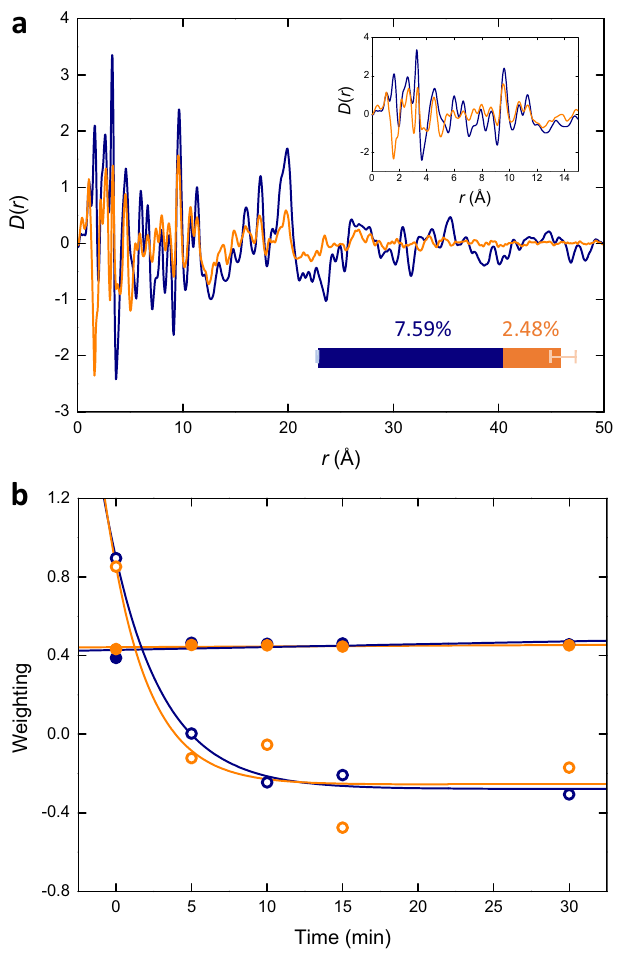
Fig. 6 Kinetic insight. a Comparison of the second principal components (distortions) obtained from the structural collapse of MIL-100 (navy) and Fe-BTC (orange). Upper inset shows the distortion at low- r . Lower inset represents the relative magnitudes of the distortion occurring upon collapse of MIL-100 (navy) and Fe-BTC (orange), uncertainties represent the variance associated with the discarded principal components. b Time- resolved weightings of the fi rst ( fi lled) and second (empty) principal components used to reconstruct the experimental PDF data, fi tted using a linear and an exponential decay function, respectively.